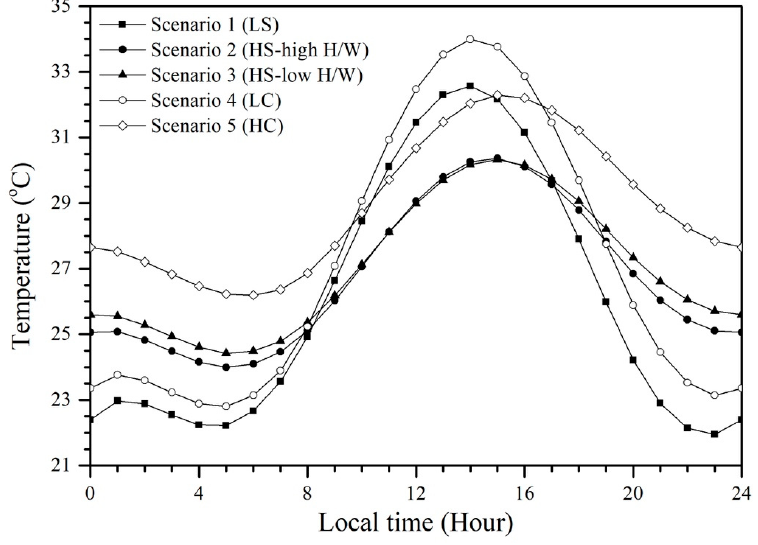
Figure 16. Daily air temperature of the different scenarios.